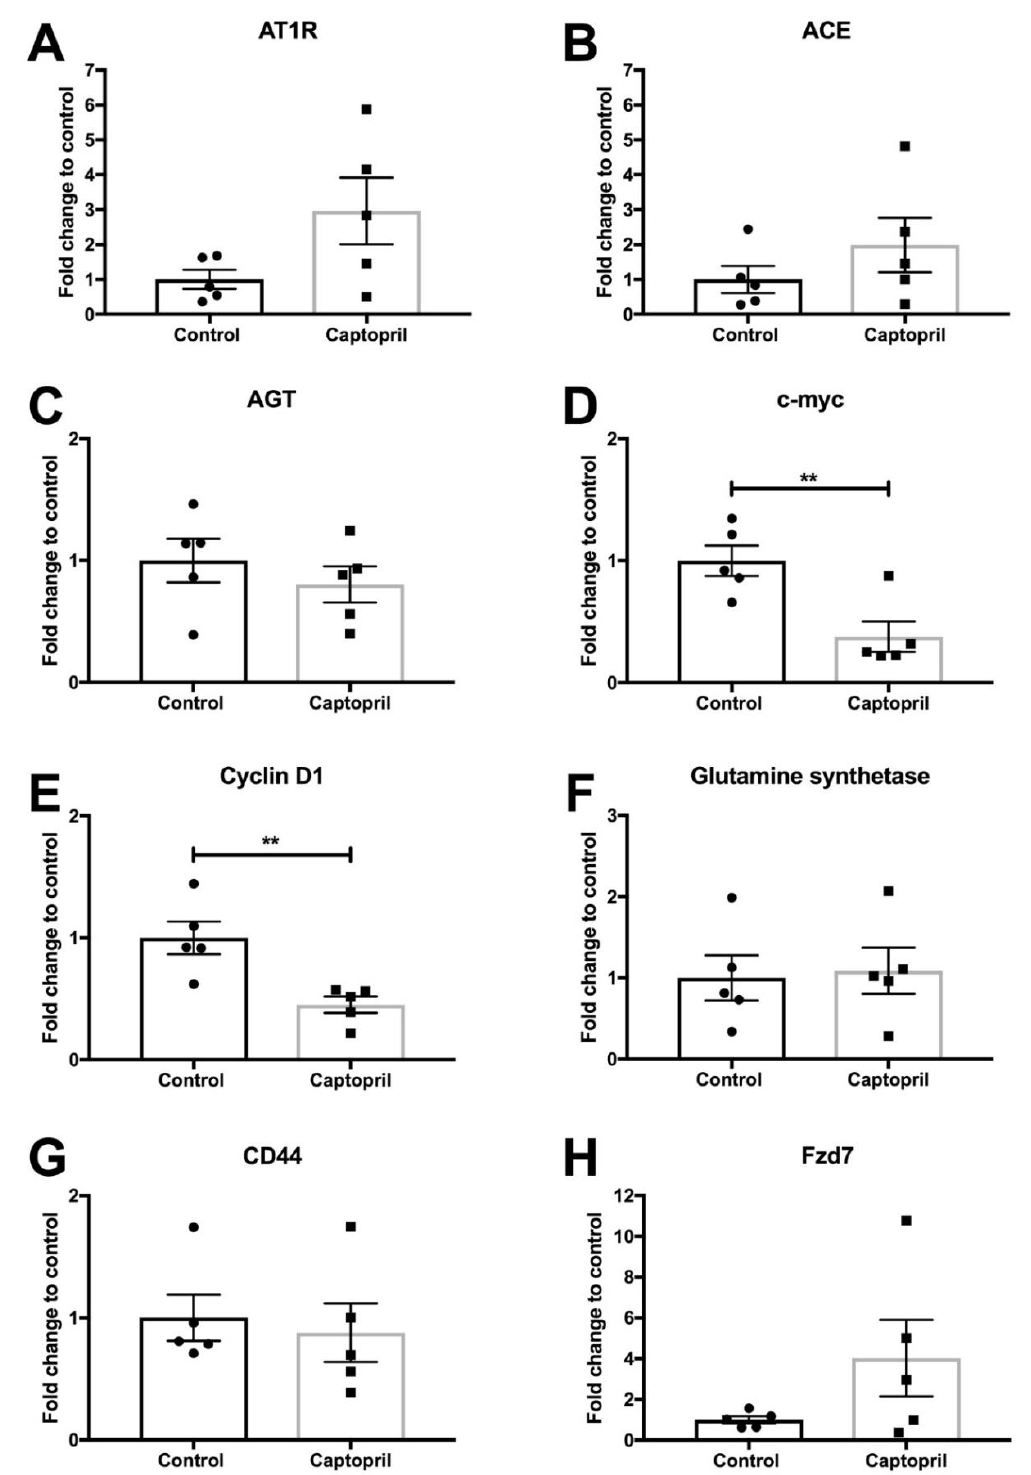
Figure 1. Gene expression (qRT-PCR) in tumor samples. Tumor tissues from control and captopril treated mice were analyzed by qRT-PCR for the expression of the indicated genes. Captopril treatment was not associated with any significant changes in ( A ) AT1R ( p = 0.0833), ( B ) ACE ( p = 0.2916), ( C ) AGT ( p = 0.4245, ( F ) glutamine synthetase ( p = 0.8281, ( G ) CD44 ( p = 0.7008 or ( H ) Fzd7 ( p = 0.1478) expression. Captopril treatment was associated with a significant reduction in ( D ) c-myc ( p = 0.0078) and ( E ) cyclin-D1 ( p = 0.0066) expression. Unpaired, two tailed T test. ** p < 0.01 ( n = 5 mice).